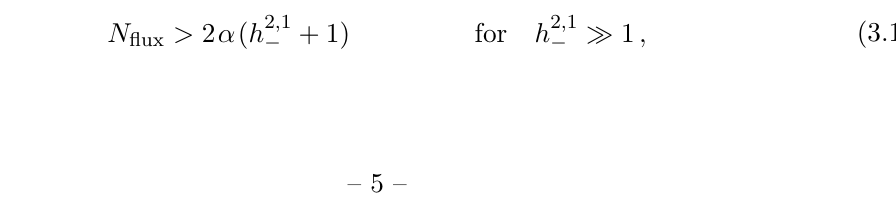
Figure 1 . (Stretched) Kähler cones shaded region is the stretched Kähler cone with parameter c